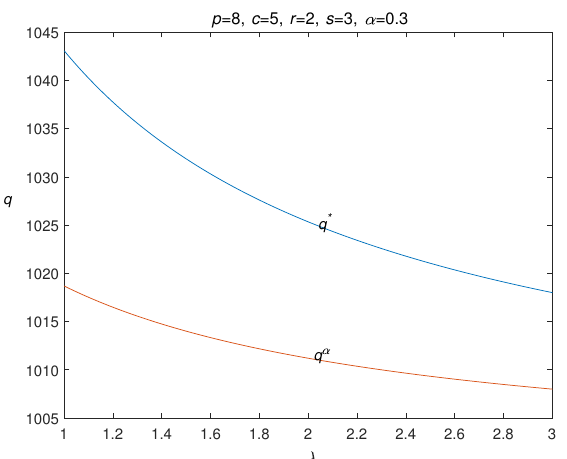
Figure 7. Optimal order quantities q ∗ and q α with different loss aversion coefficients λ